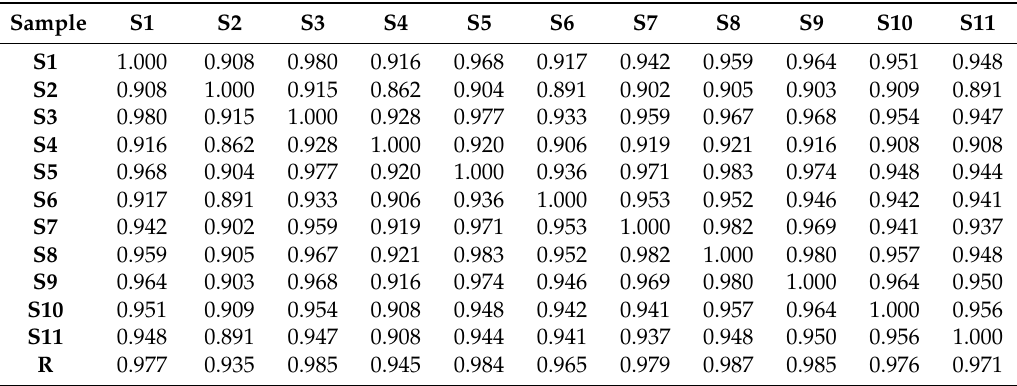
Table 3. The fingerprint similarity evaluation data.